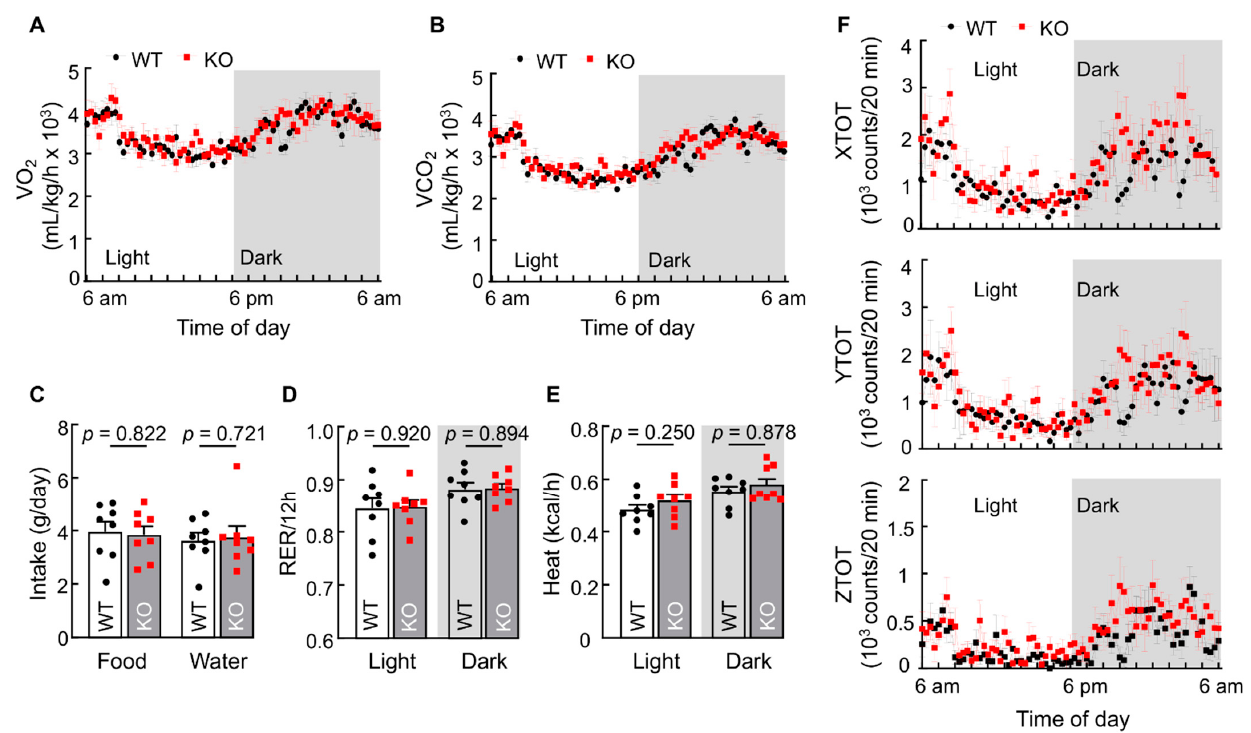
Figure 3. Basal metabolic parameters in WT and corin KO mice. ( A – E ) Representative data (mean ± SEM) of O 2 consumption ( A ) , CO 2 production ( B ), food and water intakes ( C ), respiratory exchange ratio (RER) ( D ), and heat production ( E ) in WT and corin KO mice (4–5-month-old males) monitored at RT (20–22 ° C) in 12-h light and dark cycles ( n = 8). ( F ) Motor activities of 4-5-month-old male WT and corin KO mice in 12-h light and dark cycles were monitored. Representative data (mean ± SEM) of total motor activities in X-axis (XTOT), Y-axis (YTOT), and Z-axis (ZTOT) are shown ( n = 8). Data of mean ± SEM are shown. In ( A ), ( B ), and ( F ), each dot represents the data of eight mice at the indicated time. In ( C )–( E ), each dot represents the data from one mouse in a 24-h period. p values were assessed by Student’s t test ( A , food intake in C , D , and heat production in light cycle in E , and F ) or Mann-Whitney test ( B , water intake in C , and heat production in dark cycle in E ).